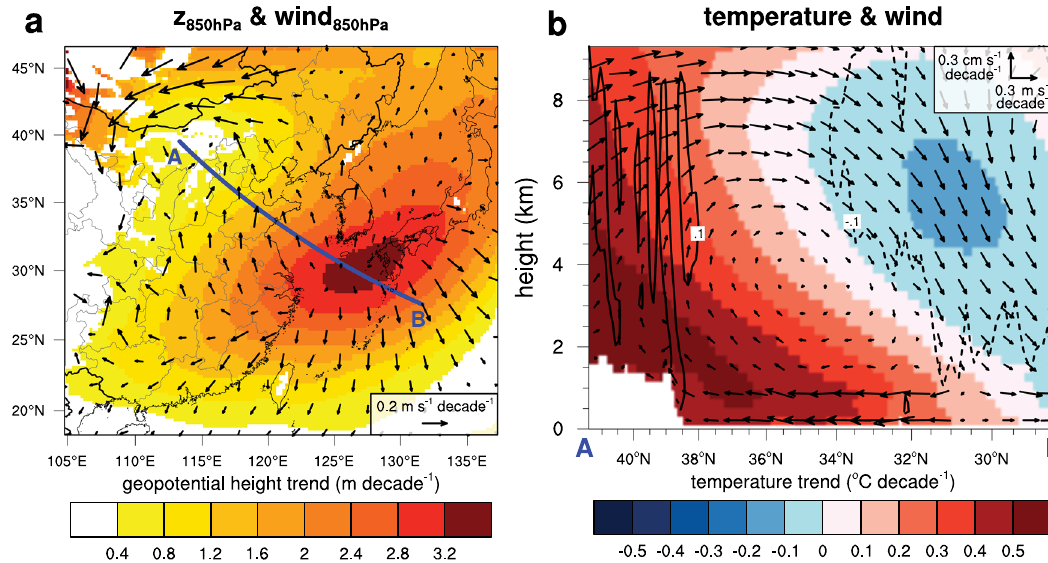
Fig. 3 Thermal circulation induced by uneven temperature increases. a Scaled trends in March – April mean geopotential height and horizontal winds at 850 hPa computed with the HIGH T_CLEAN and LOW T_CLEAN simulations in 2018. b Vertical cross-sections of temperature (shading) and meridional-vertical winds (vectors) trends along line A – B shown in a . The solid (dashed) contours indicate the vertical wind trends of 0.1 ( − 0.1) cm s − 1 decade − 1 . Note that the unit of vertical wind is cm s − 1 decade − 1 and that of meridional wind (positive northward) is m s − 1 decade − 1 , and that the leftward is the northward in b